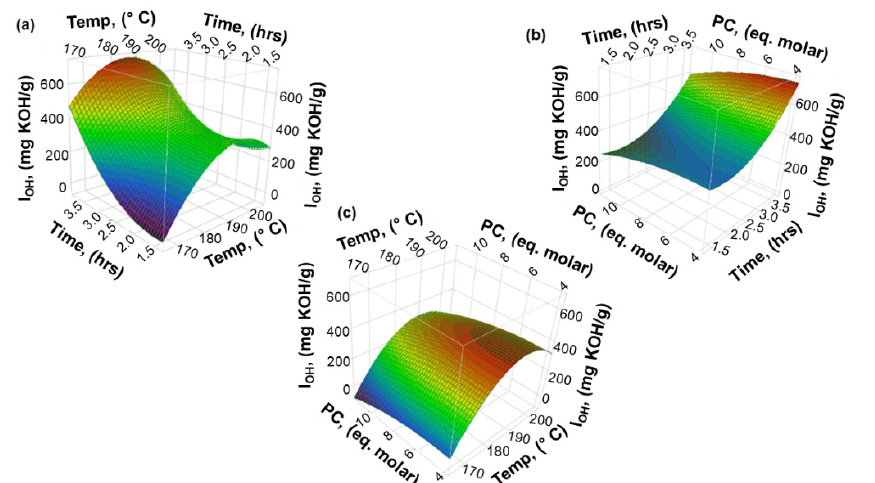
Figure 8. Three-dimensional surface plots for the hydroxyl number (I OH ) of lignin-based polyol. ( a ) The interaction effectTemp. and Time on the hydroxyl number, ( b ) The interaction effect Time and PC on the hydroxyl number, ( c ) The interaction effect Temp. and PC on the hydroxyl number.